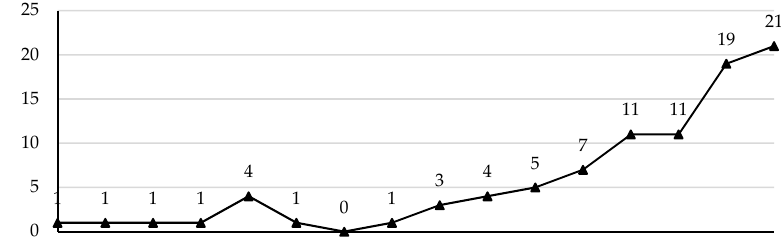
Figure 2. The number of selected articles published per year.